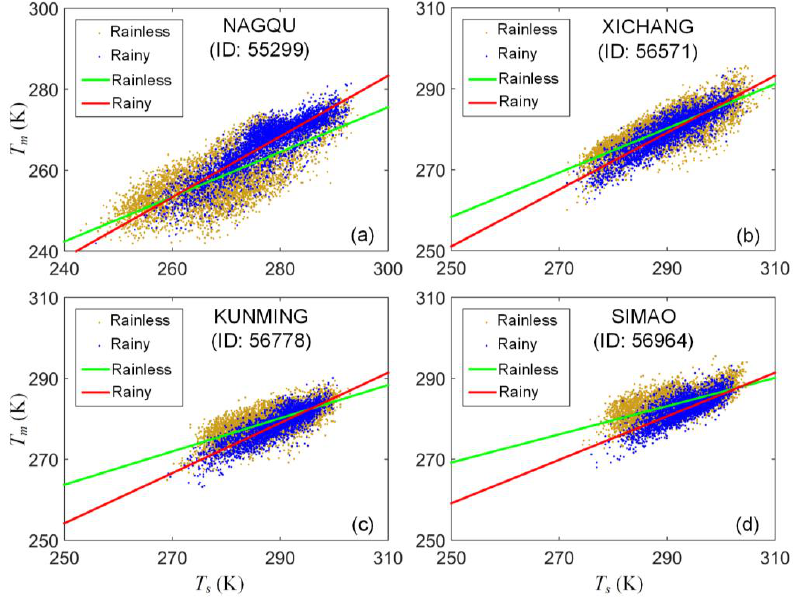
Figure 8. Rainy-day model and rainless-day model for station ( a ) NAGQU, ( b ) XICHANG, ( c ) KUNMING, and ( d ) SIMAO. The green lines are the rainless-day models and the red lines are the rainy-day models. The golden dots are the radiosonde data from rainless days and the blue dots are the data from rainy days.